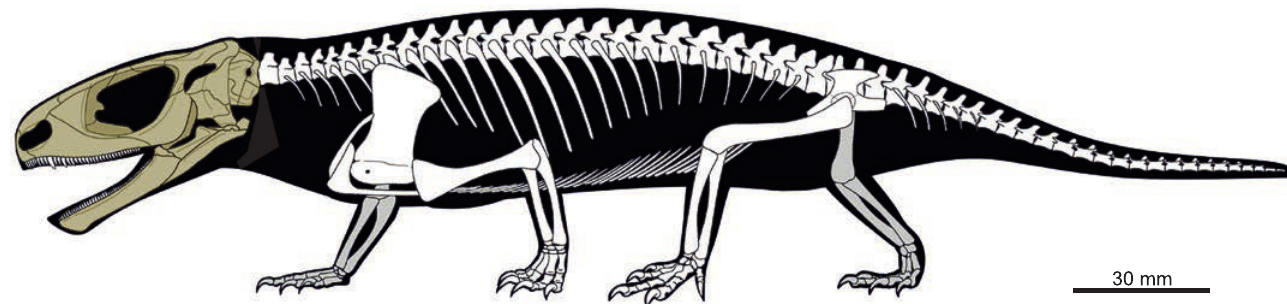
Fig. 2. Reconstructed skeleton of Candelaria barbouri depicting the preserved elements (in brown) of CAPPA/UFSM 0225 (by Maurício S.